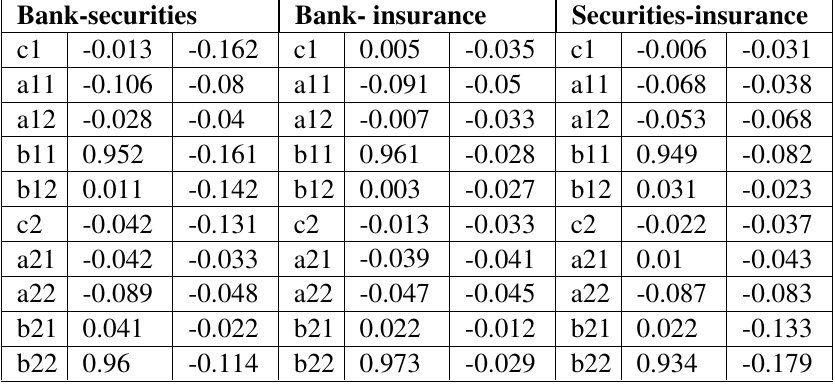
Table 2 Estimated results of the MVMQ-CAViaR model in the financial